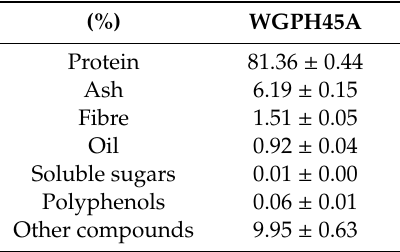
Chemical composition of WGPH45A. Values, showed as a percentage in dry basis, are mean ± standard deviation of triplicates.